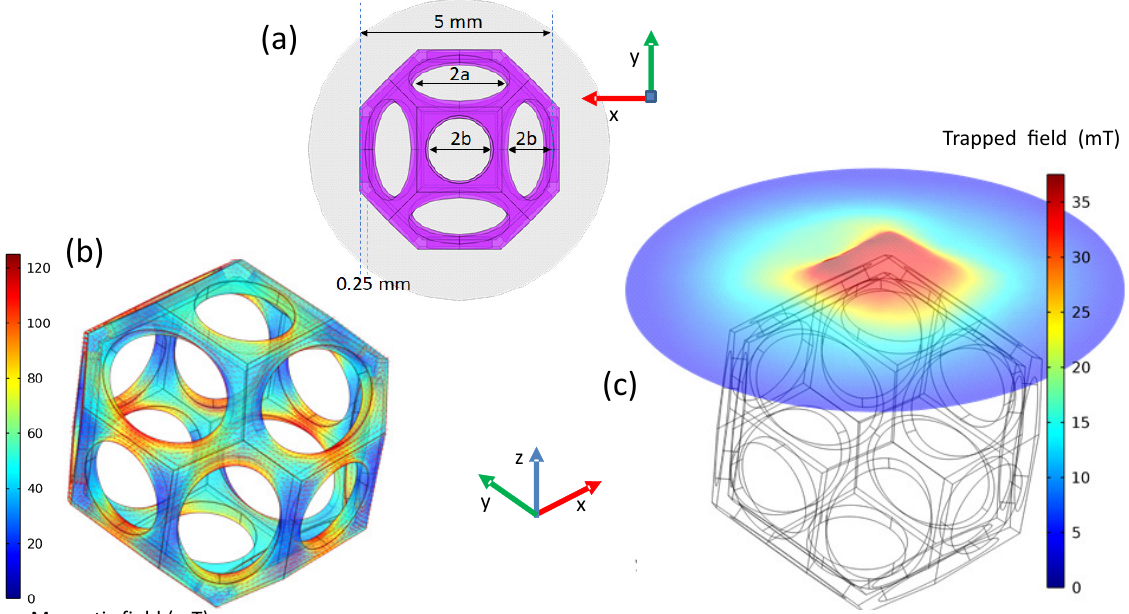
Figure 8. First modelling of trapped fields of a foam using the Kelvin cell, the dimensions of which are given in ( a ). ( b ) presents the distribution of the local magnetic field after field cooling in a field of 50 mT, and ( c ) gives the trapped field distribution at 2.75 mm above the